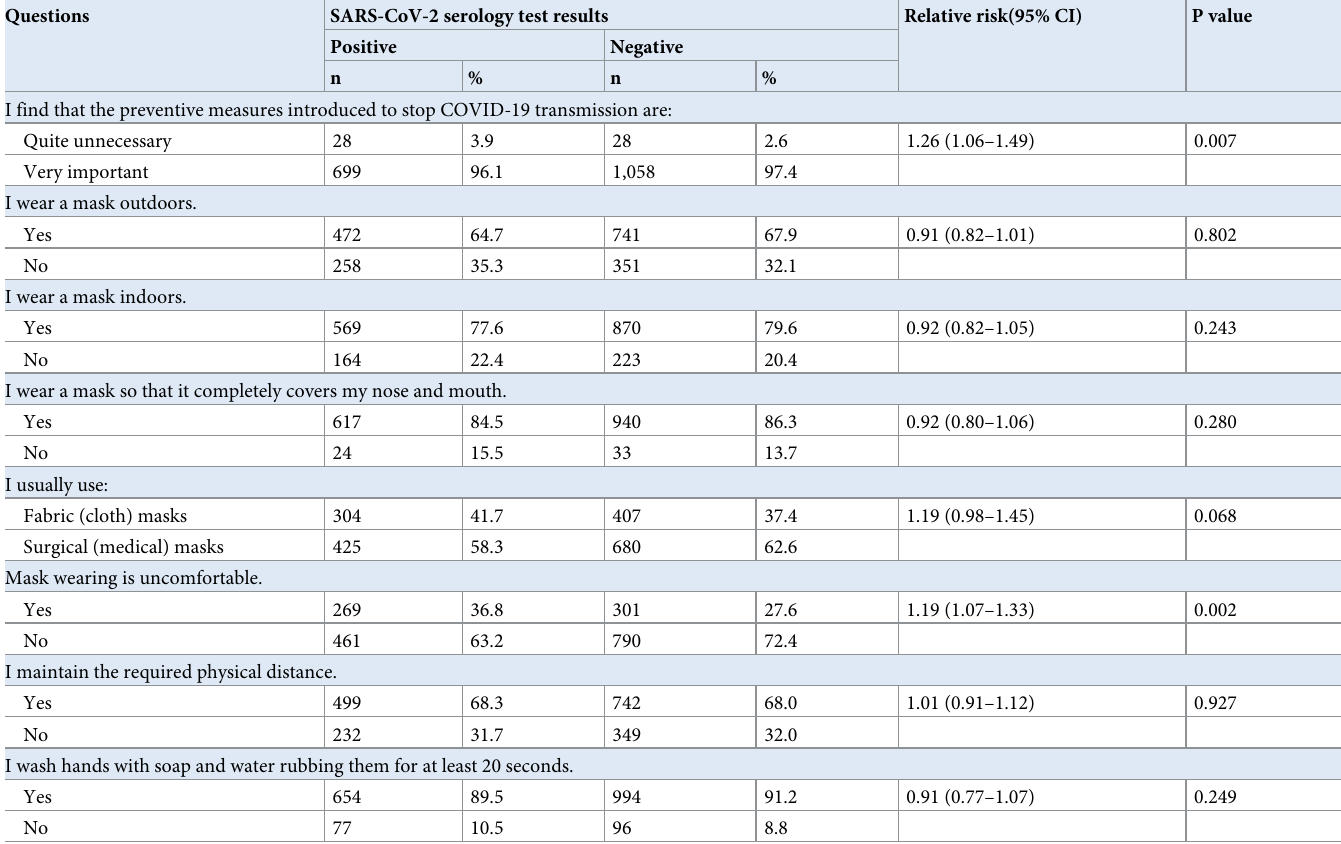
Table 5. Compliance with recommended preventive